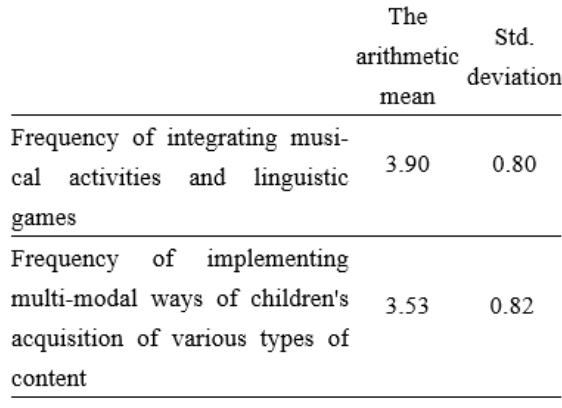
Table 5. Frequency of conducting mul- ti-modal activities in educational practice